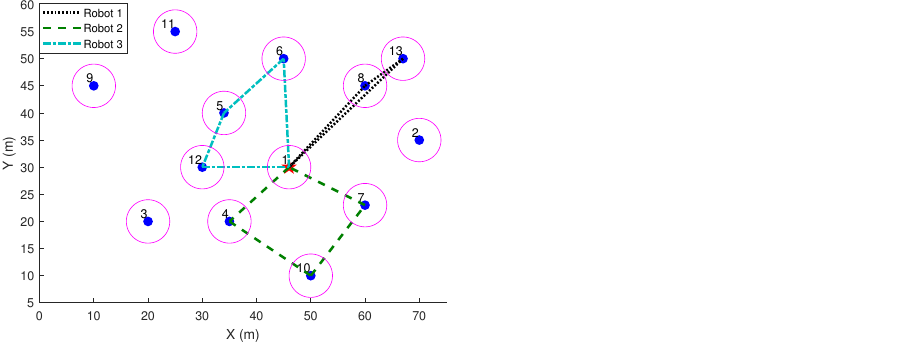
Figure 5. Mobile Element Scheduling Routes with 3 MoEls and 13 Nodes—No priorities